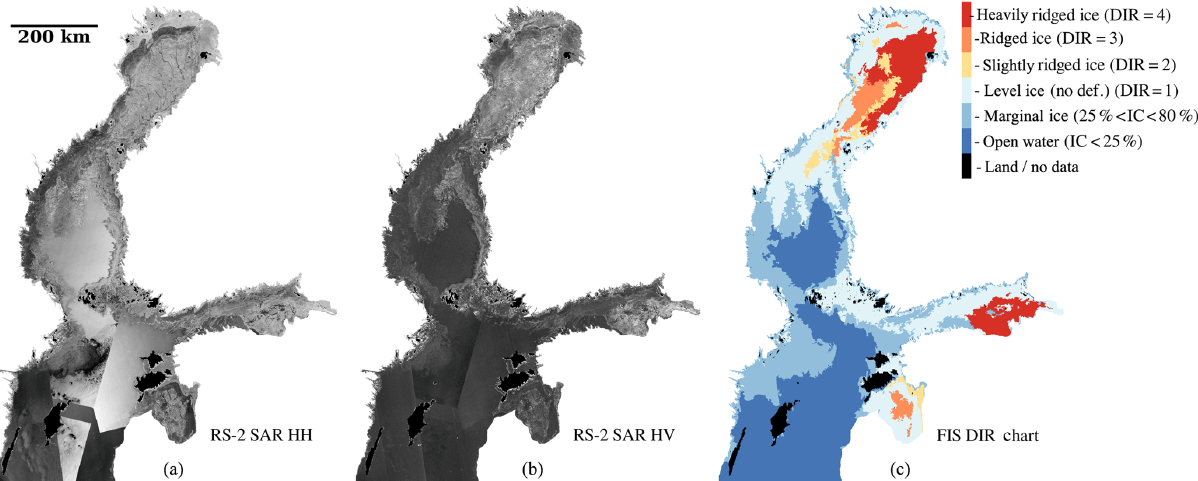
Figure 1. Example of RS-2 dual polarized SAR image mosaic ( a : HH, b : HV) over the Baltic Sea on 15 March 2013 and the corresponding DIR chart (c) showing the manually drawn polygons of different degrees of ice ridging, including the marginal ice zone detection mask based on the ice concentration values between 25 and 80% and open-water mask based on the ice concentration values smaller than